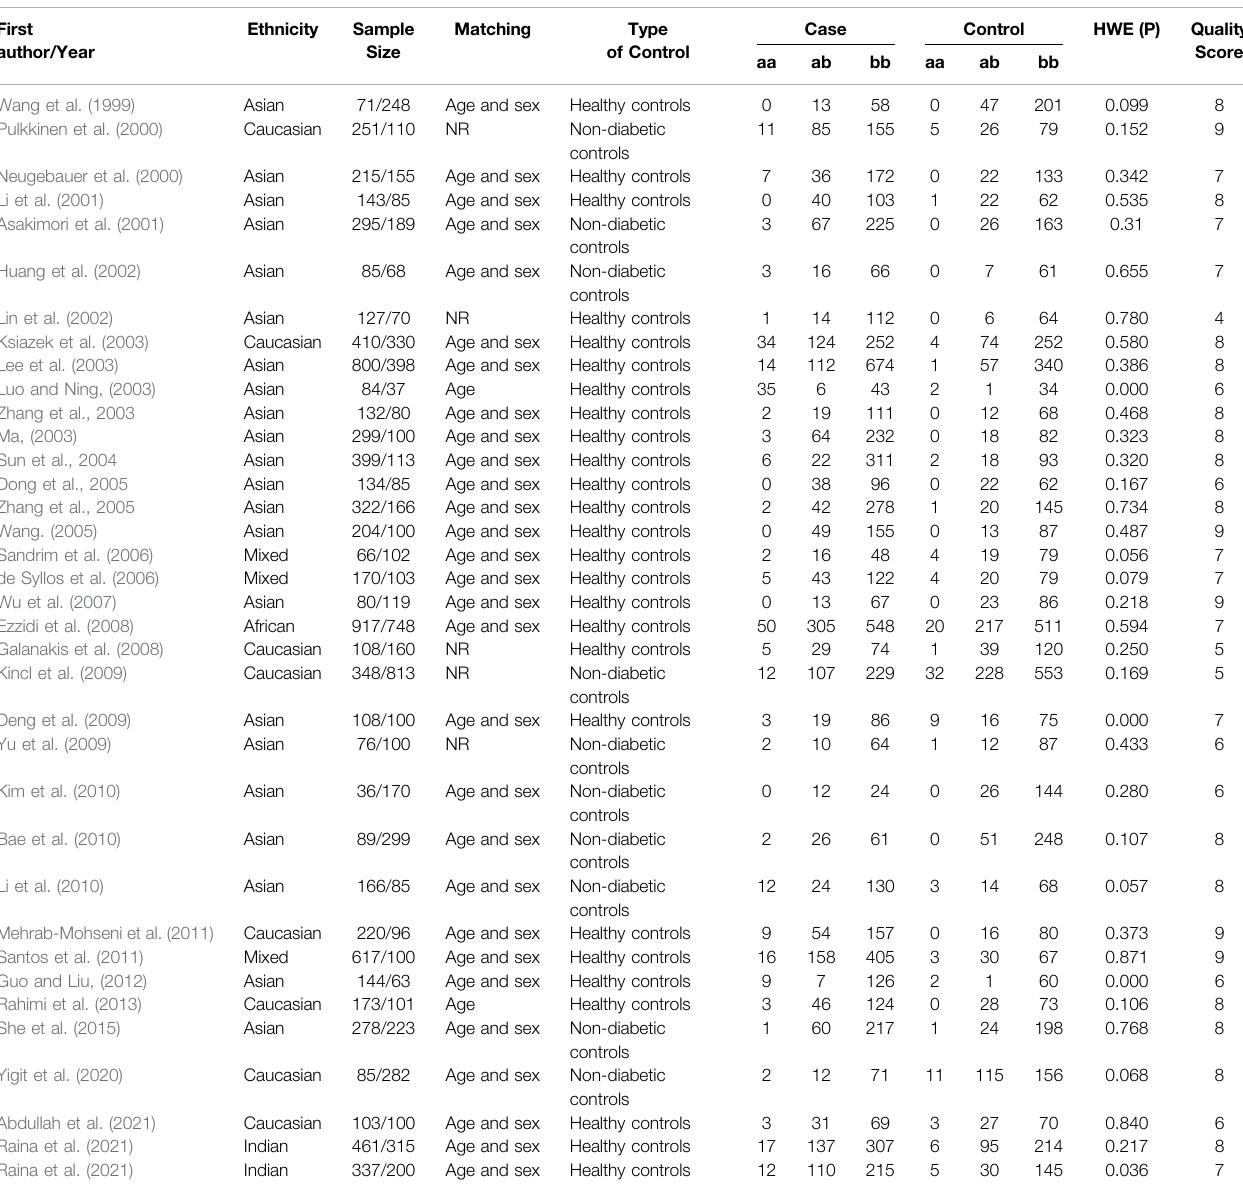
TABLE 2 | Genotype distribution of eNOS 4b/a polymorphisms in the included studies of